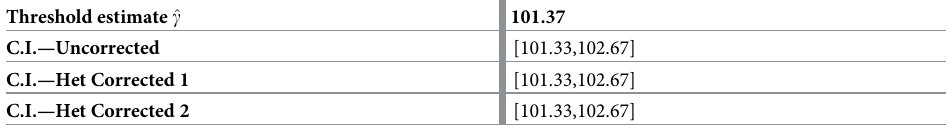
Table 4. The threshold estimates from two-stage least squares estimation for the threshold